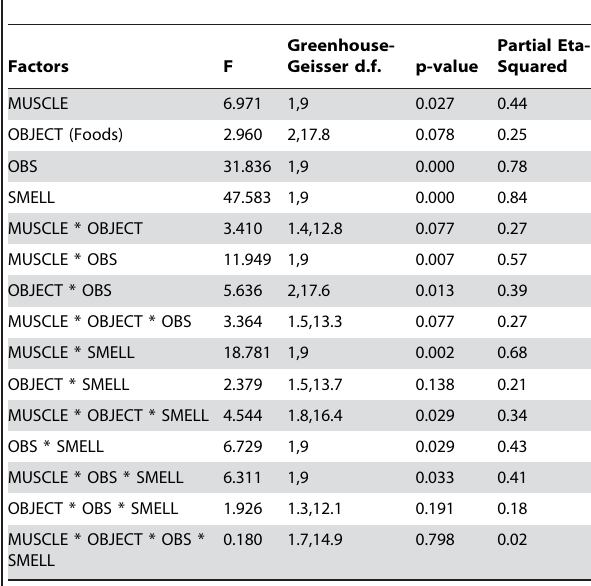
Table 1. Main analysis (factorial ANOVA) of the Experiment 2 for the three